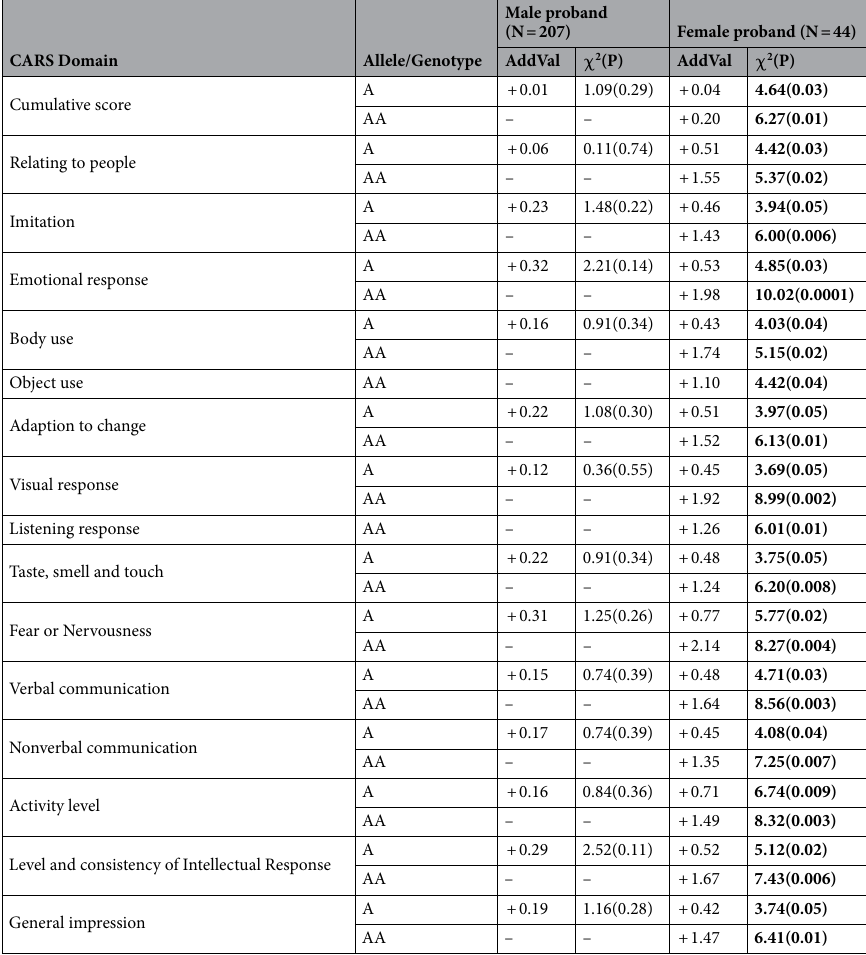
Table 4. Association between rs3810651 alleles/genotypes and traits of ASD probands (N.B. Only statistically significant values are presented for female